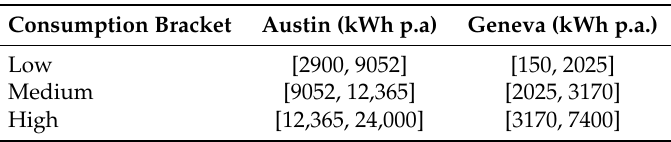
Table 1. Consumption brackets per